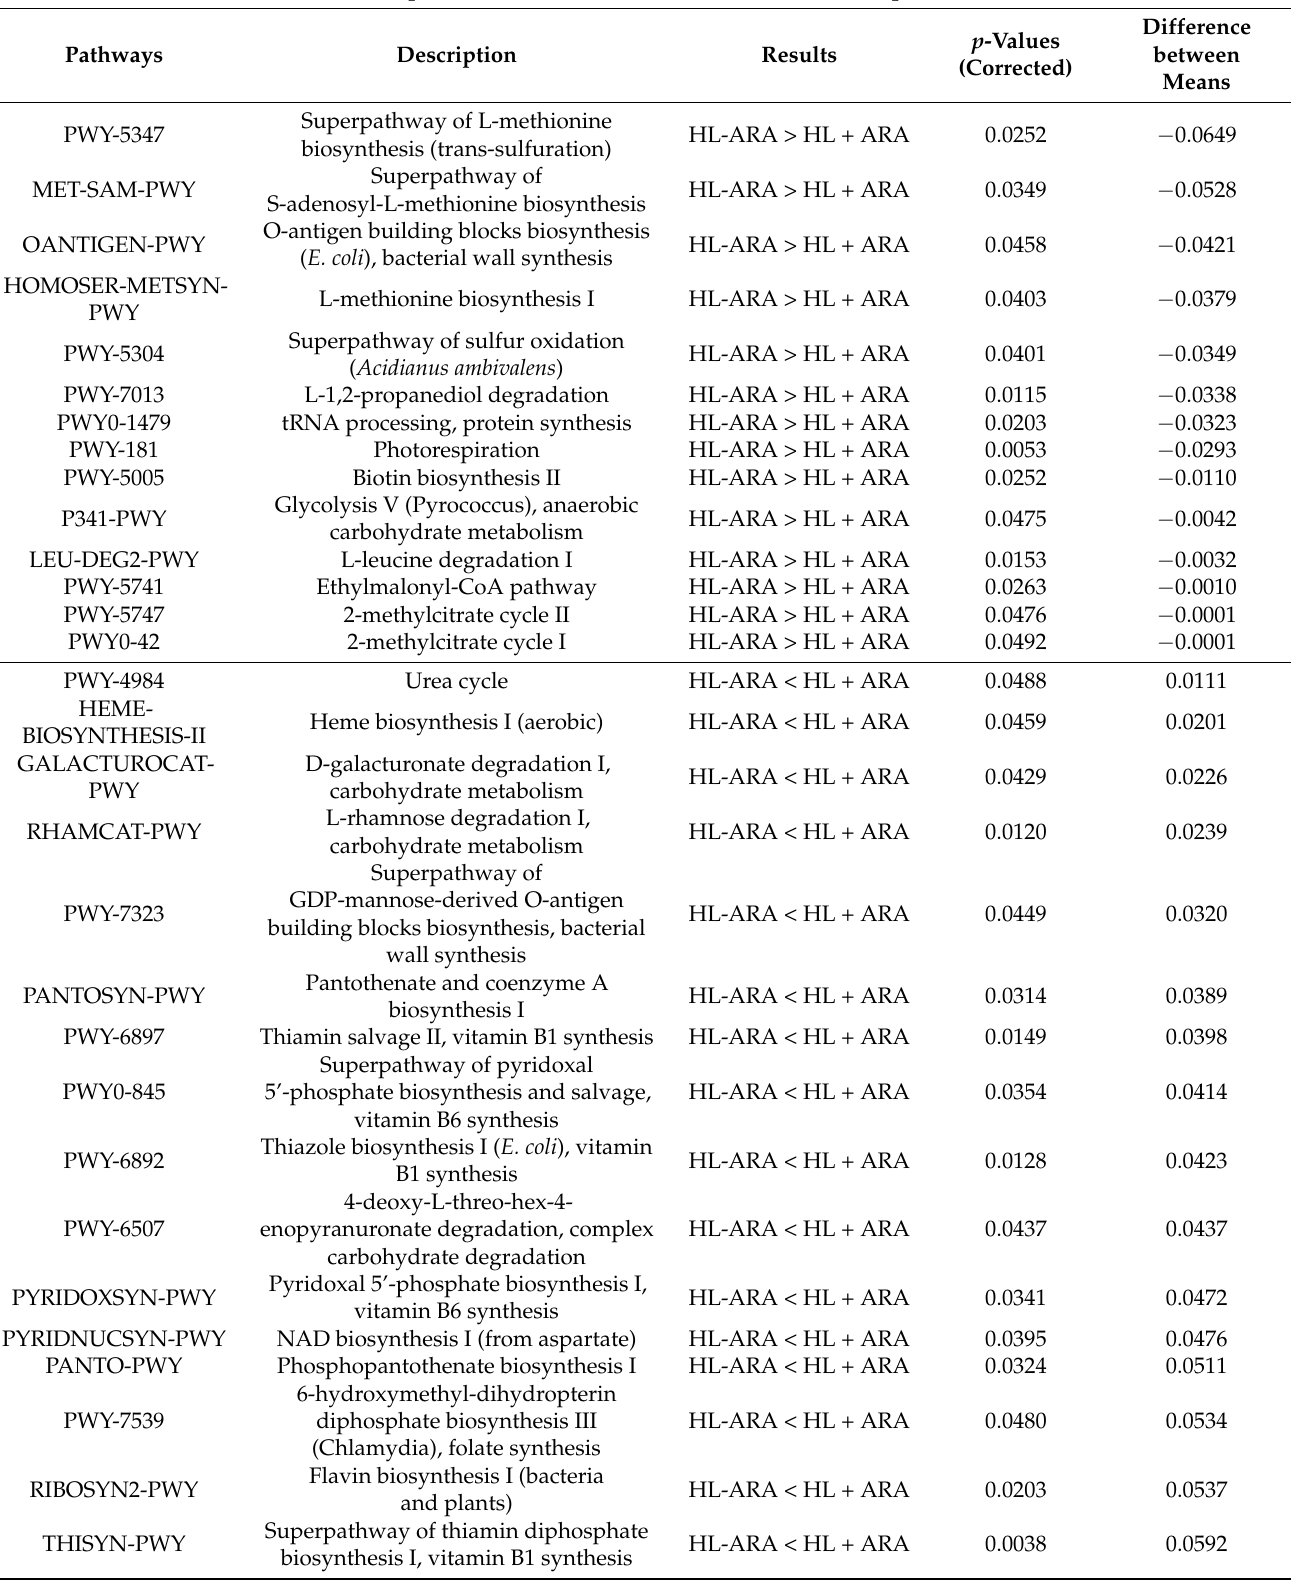
Table 4. Cont. Comparison between HL-ARA and HL + ARA